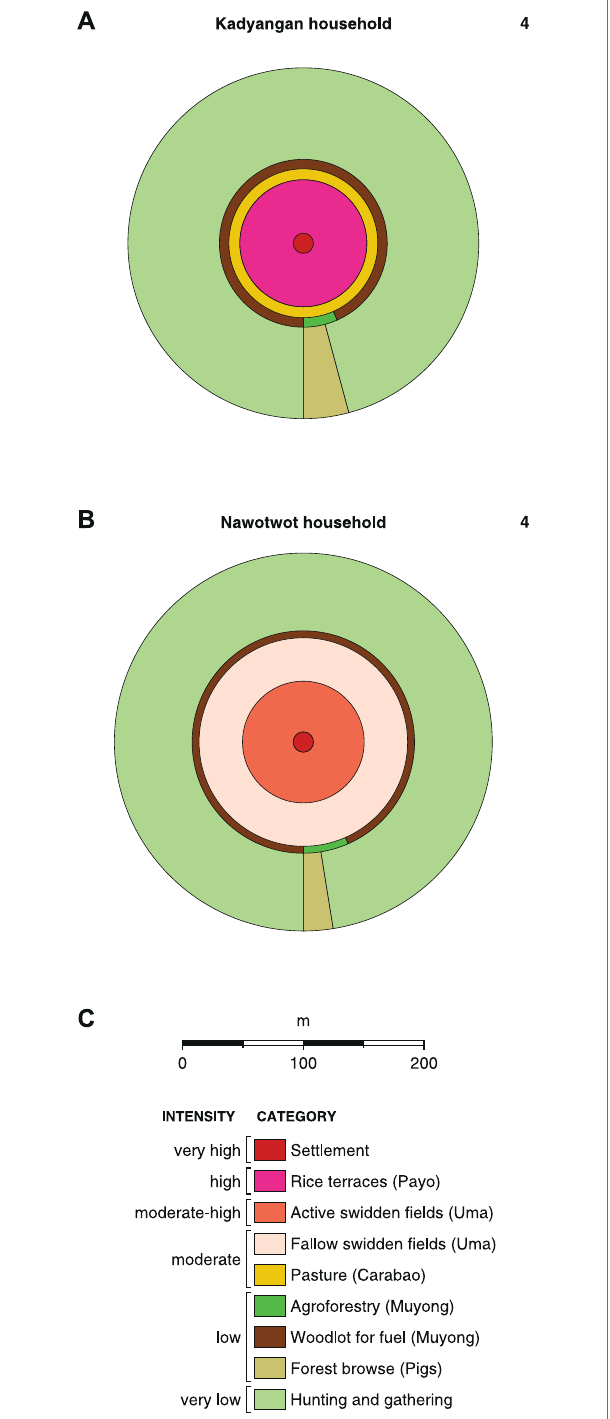
FIGURE 4 | Circle diagrams describing the hypothetical land use of a kadangyan family of 4 ( Panel A) and a nawotwot family of 4 ( Panel B) . As with Figure 3 , a legend with a scale is also included ( Panel C) . In each panel, the number in the upper right corner represents the population whose land use is being